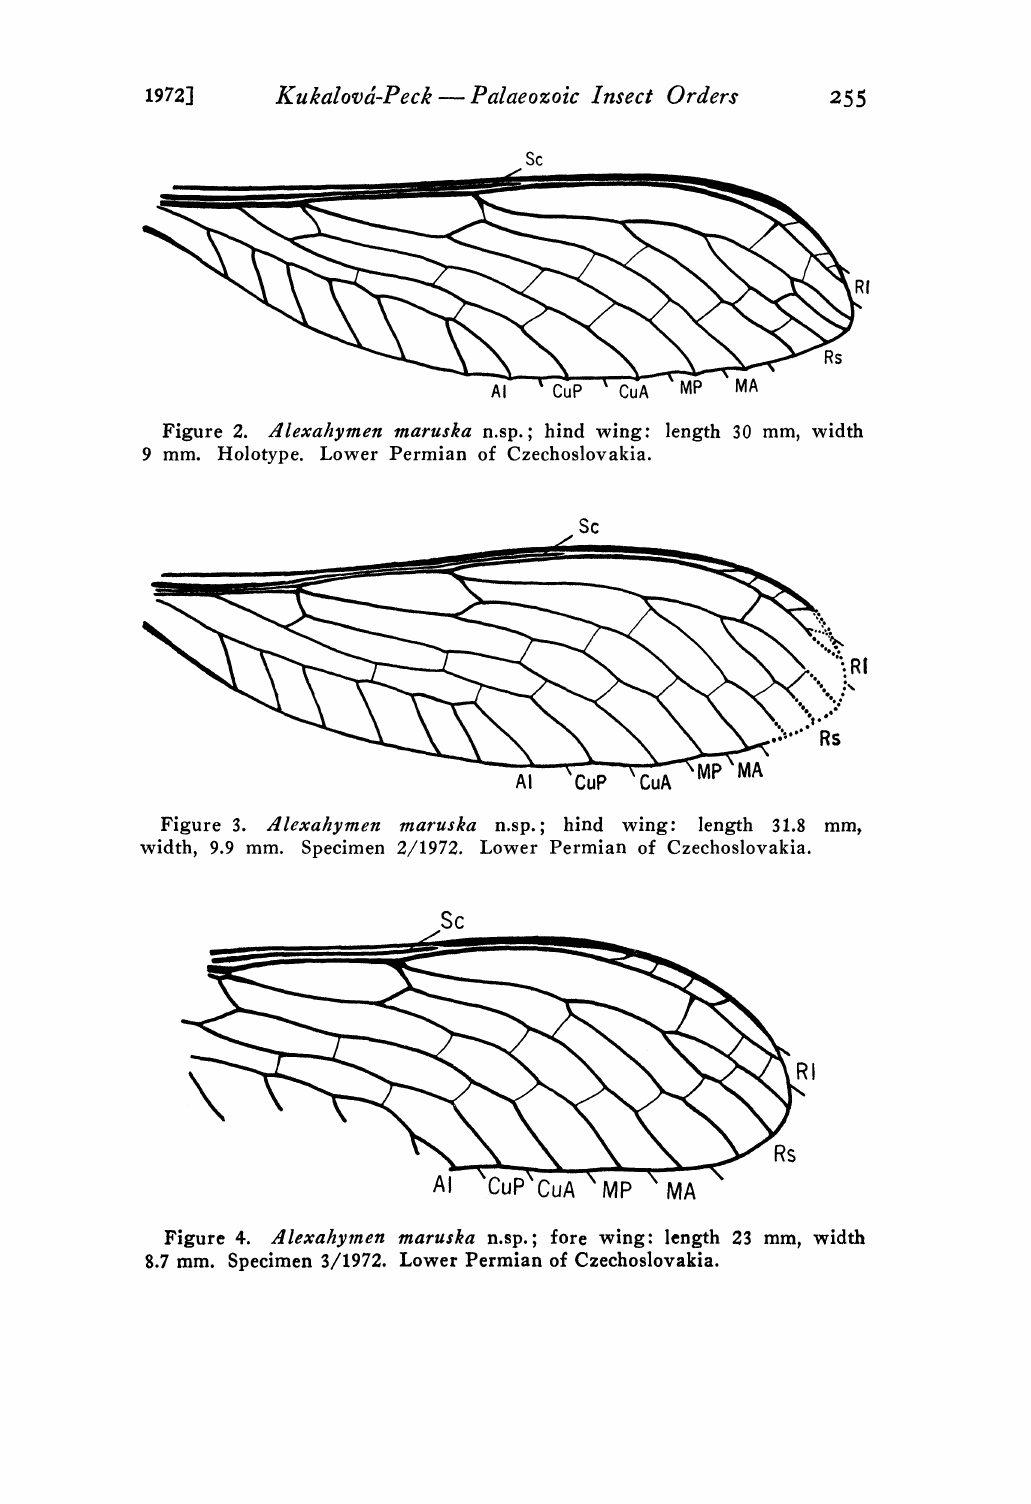
AI MA /llexahymen maruska n.sp.; fore wing: length 23 mm, width Figure 4-. 8.7 mm. Specimen 3/1972. Lower Permian of